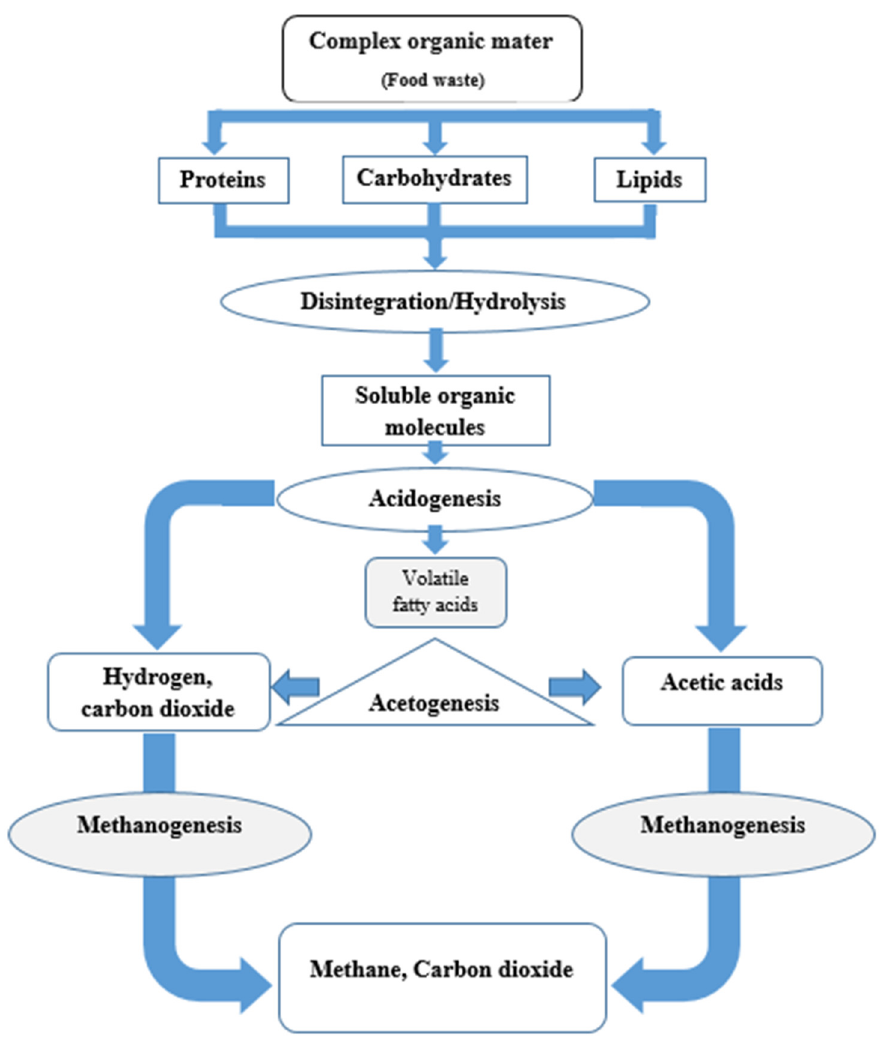
Figure 2. Different phases of anaerobic digestion .